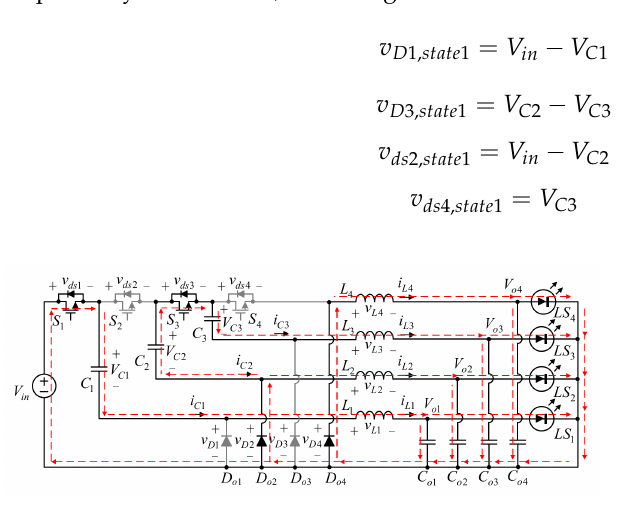
Figure 4. Current flow in state 1 in CCM.